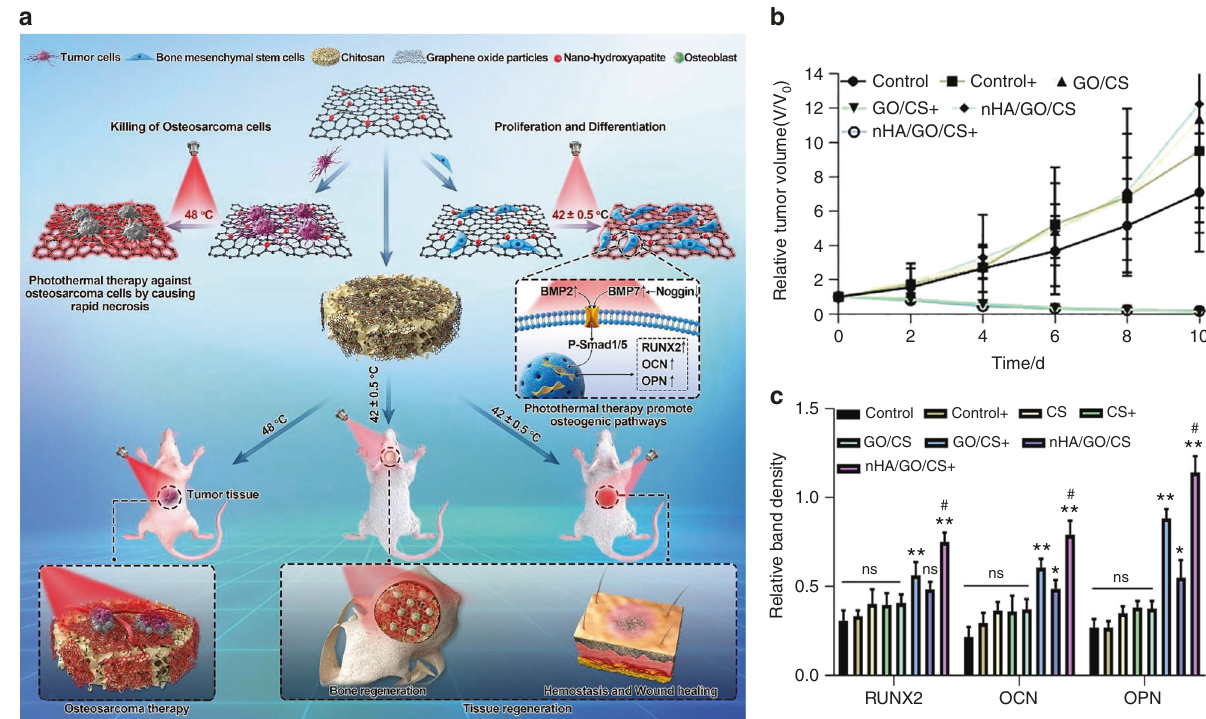
Fig. 3 nHA/GO/CS scaffolds for both disease therapeutic and bone regeneration. a Scheme to manifest the fabrication of nHA/GO/CS scaffolds with bifunctionalities of both therapeutic and regeneration. b Tumor volume changes after different treatments with time (days). c Quantitative analyses of various proteins with or without NIR exposure after 14 days of osteogenic culture (** P < 0.01, * P < 0.05). Reproduced with permission. 55 Copyright 2020,